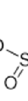
Figure 1. Structure of busulfan.